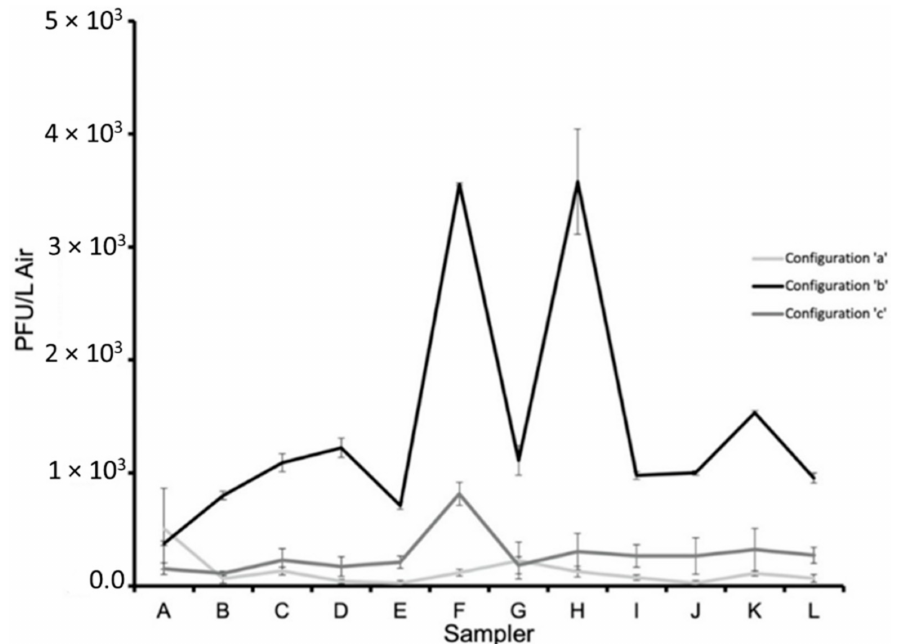
Figure 15. The average PFU/L Air at each sampler at the twelve locations A, B, C, D, E, F, G, H, I, J, and K for each of the configurations, a, b, and c. All PFU/L Air counts were normalized based on the stock PFU counts from the configuration ‘b’ testing (Table S8 in Supplementary